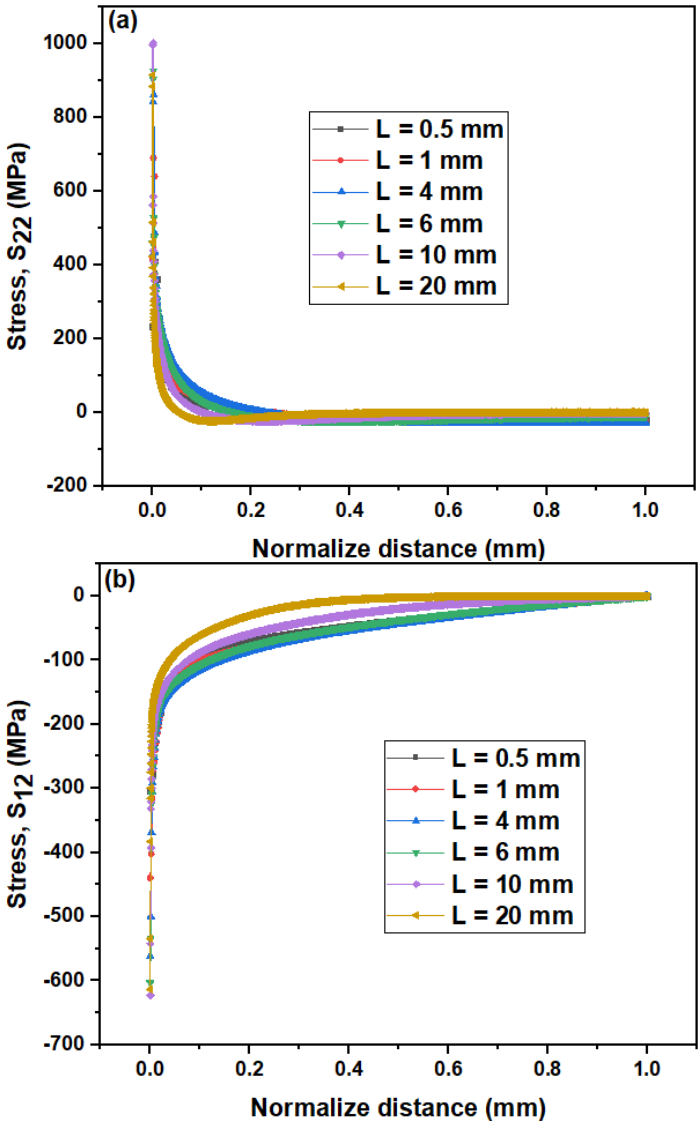
Figure 4. The stress distribution ( a ) S 22 and ( b ) S 12 at the crack tip under different SVC along the pre-crack path.